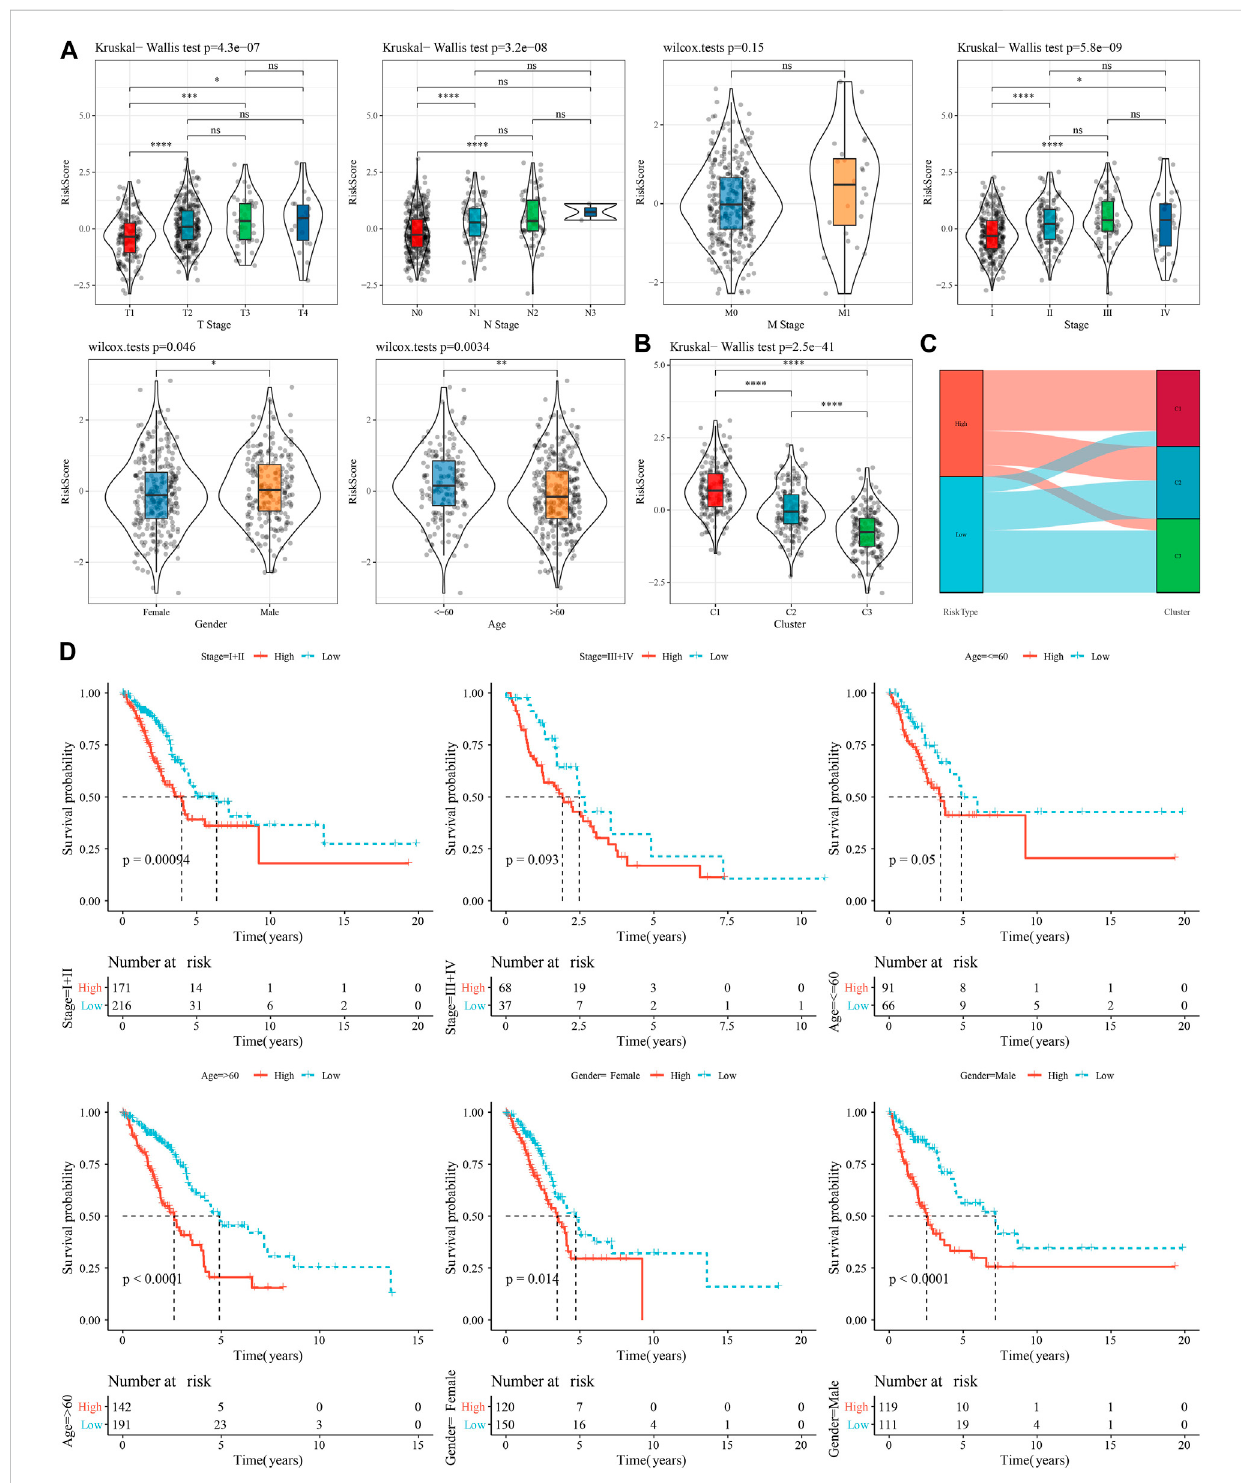
FIGURE 8 Performance of RiskScore in TCGA-LUAD cohort with different clinicopathological characteristics. (A) Differences between RiskScore between differentclinicopathologicalsubgroupsintheTCGA-LUADcohort. (B) DifferencesinRiskScorebetweendifferentmolecularsubtypesintheTCGA-LUAD cohort. (C) Differences between molecular subtypes and RiskScore subgroups in the TCGA-LUAD cohort. (D) KM curves between high- and low-risk groups in the TCGA-LUAD cohort between different clinicopathological